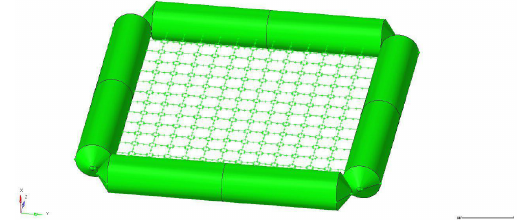
Fig. 2. Sketch of the freshwater floating platform